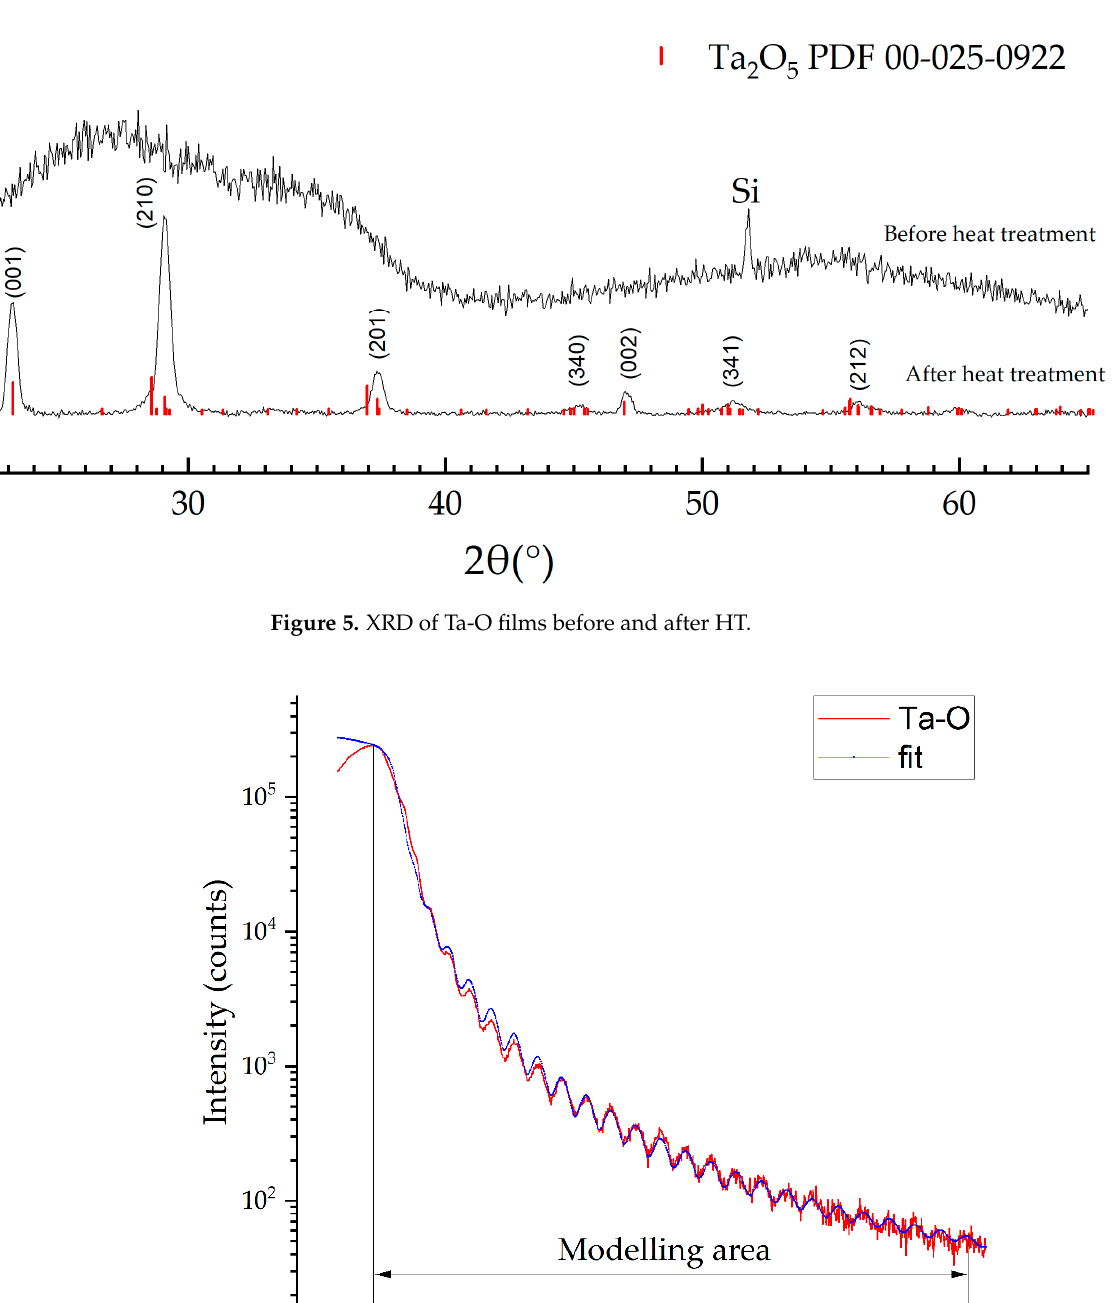
Figure 6. X-ray reflectometry of the Ta-O_6 sample before HT.